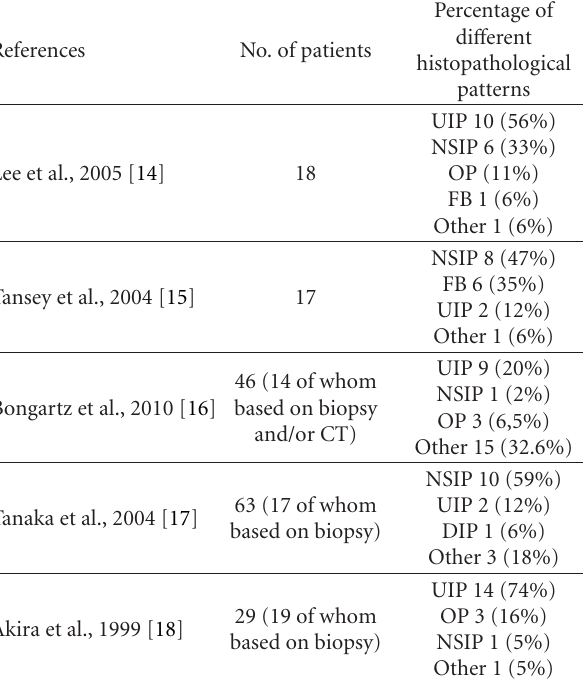
Table 1: Histopathological patterns of RA-associated